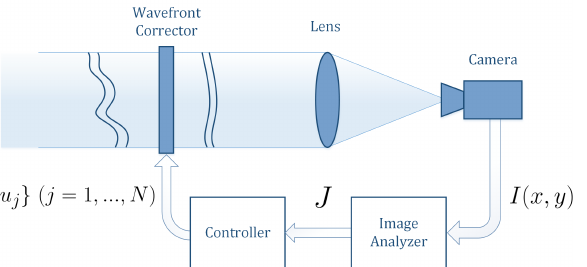
Figure 1. Schematic of a wavefront sensor-less (WFSless) adaptive optics (AO)